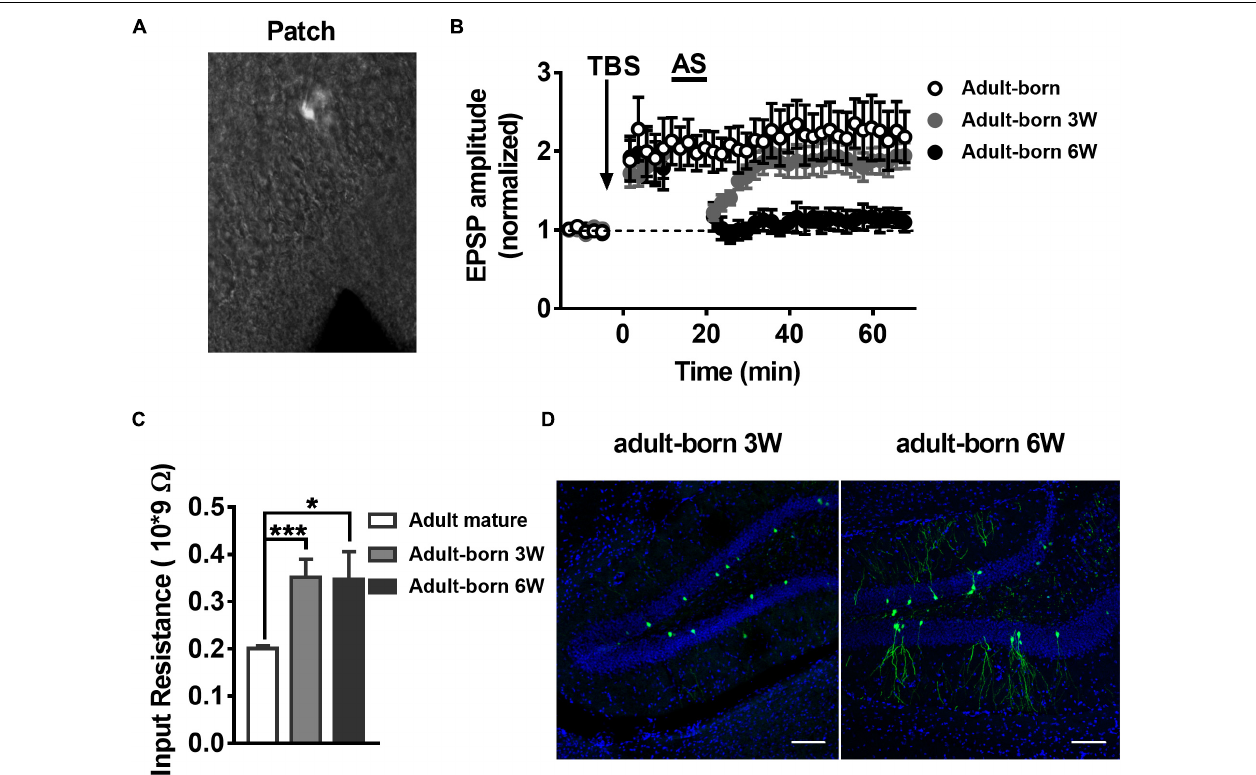
FIGURE 2 | LTP and LTP reversal vary with the developmental stage of the adult-born DGCs in the hippocampus. (A) A photograph of the EPSP recording setup by patch-clamp in adult-born DGCs expressing GFP from retrovirus injected mice. (B) LTP in adult-born DGCs (open circles) and LTP reversal in adult-born 3-week-old (gray-solid circles) and adult-born 6-week-old (black-solid circles) DGCs. LTP was successfully reversed in adult-born 6-week-old DGCs but not in adult-born 3-week-old DGCs after delivering the AS. (C) Input resistance in adult mature DGCs (white bar) and adult-born 3-week-old (gray bar) and adult-born 6-week-old (black bar) DGCs. Input resistance changed with the development of adult-born DGCs. Values represent the mean ± SEM ( ∗ p < 0.05; ∗∗∗ p < 0.001; unpaired t -test). (D) Confocal images of GFP + flourscence (green) and DAPI staining (blue) in newborn 3-week-old and newborn 6-week-old DGCs from the adult hippocampus. Scale bar, 100 µ